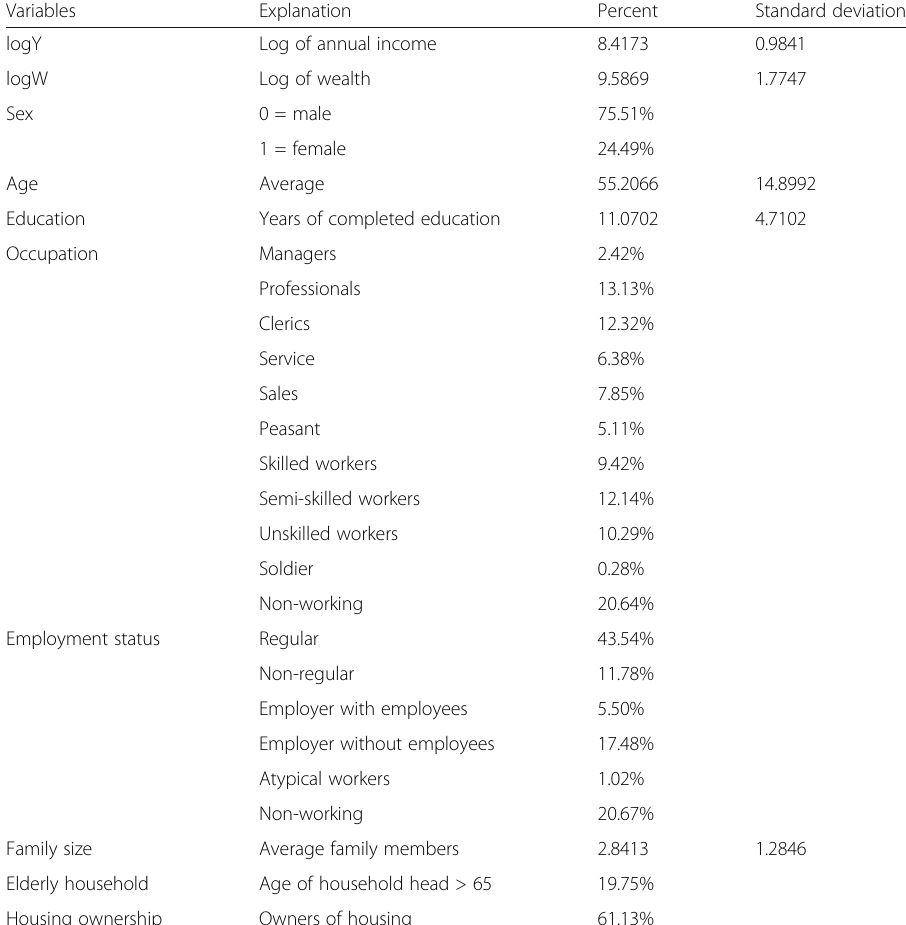
Table 2 Descriptive summary of major variables ( N =